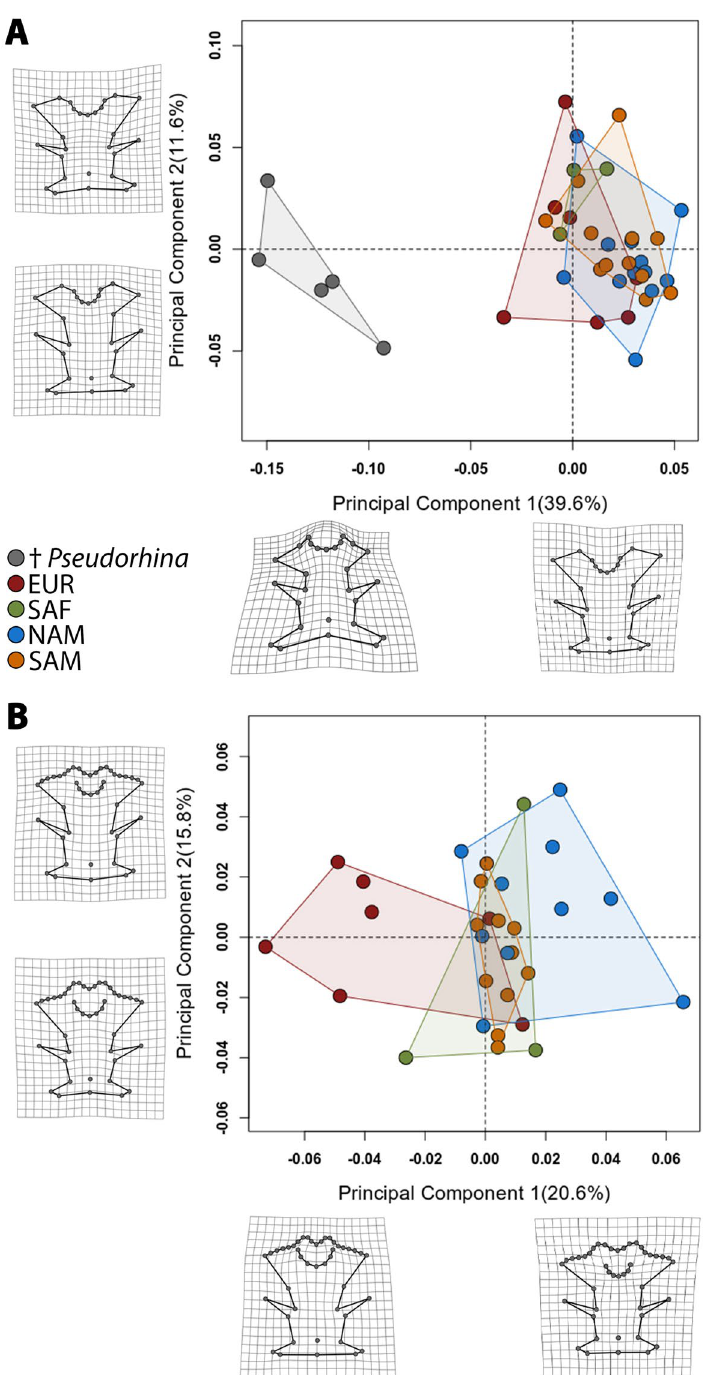
Figure 2. Morphospace of the neurocranium for the extant clades and fossil angel sharks ( A ). Morphospace of the neurocranium of only the extant clades of angel sharks ( B ). Deformation grids indicate the minimum and maximum value of the principal component 1 and